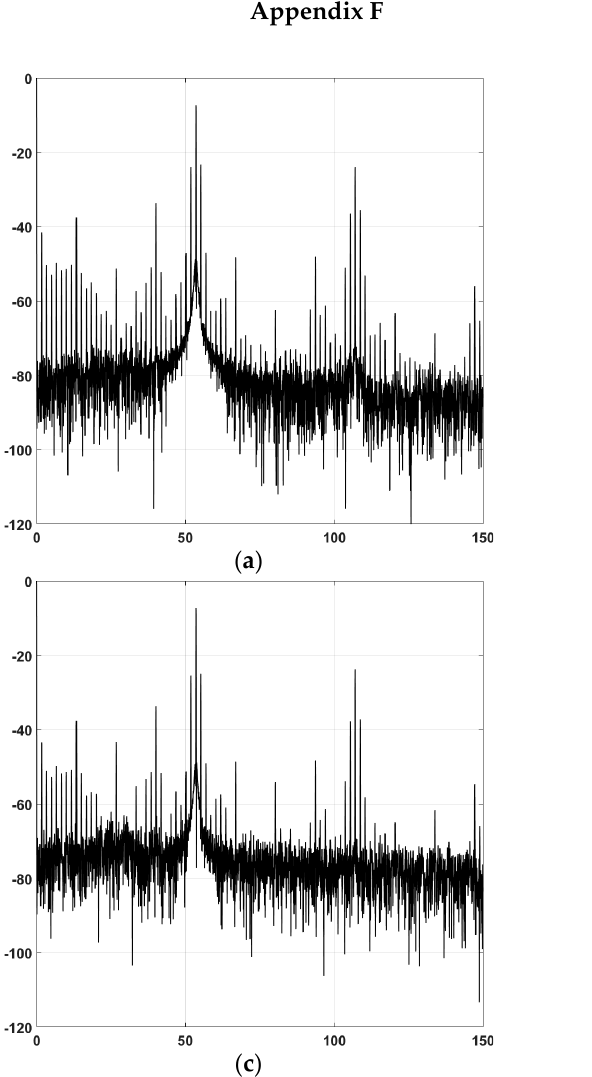
Figure A6. Experimental results. EPVA spectrum of the generator at 100 rpm: ( a ) Local demagnetization 5 kW; ( b ) Local demagnetization 4 kW; ( c ) Local demagnetization 2 kW; ( d ) Local demagnetization 1 kW.